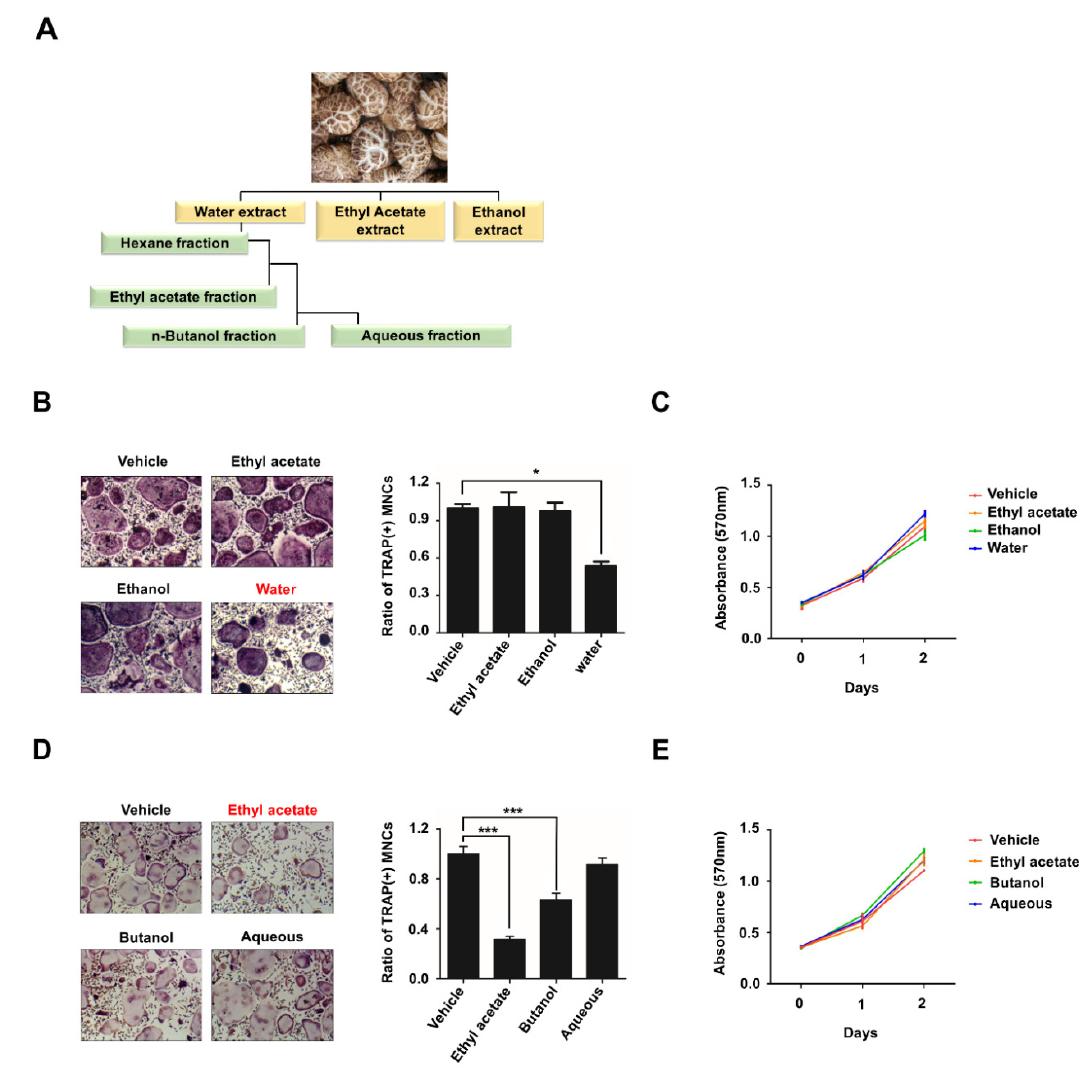
Figure 1. Ethyl acetate fraction of aqueous extract of Lentinula edodes inhibits RANKL-mediated osteoclastogenesis. ( A ) Schematic representation showing the extraction and fractionation of anti-osteoclastic compounds from L. edodes . ( B ) BMMs were treated with M-CSF (30 ng / mL) and RANKL (100 ng / mL) in the presence or absence of 10 µ g / mL three extract (water extract, ethyl acetate extract, ethanol extract) of L. edodes for three days, and osteoclast formation was examined by tartrate-resistant acid phosphatase (TRAP) staining ( left ) and counting the number of TRAP-positive multinuclear osteoclasts ( right ). ( C ) BMMs were treated with M-CSF (30 ng / mL) and RANKL (100 ng / mL) in the presence of the extracts as in ( B ), and cell proliferation was measured by MTT assays. ( D ) BMMs were treated with M-CSF (30 ng / mL) and RANKL (100 ng / mL) in the presence of four fractions (10 µ g / mL) of water extract of L. edodes for three days, and osteoclast di ff erentiation was assessed by TRAP staining (left) and the number of TRAP-positive multinuclear osteoclasts (right) was counted. ( E ) BMMs were treated with the fractions as in (D), and cell proliferation was measured by MTT assays. Error bars represent the mean result ± SD of three independent experiments; * p < 0.05, *** p < 0.001. 2.2. LEA Modulates a Set of Osteoclast-Related Gene Expression in RANKL-Induced Osteoclastogenesis To elucidate the inhibitory mechanism of LEA on RANKL-induced osteoclast differentiation, we performed genome-wide transcriptome analysis of BMMs with or without LEA during RANKL- mediated osteoclastogenesis. Analysis of RNA-seq data revealed 4740 differentially expressed genes in any pairwise comparison among the three conditions (no RANKL (-R), RANKL (R), RANKL + LEA (R+LEA)). K-means clustering classified the genes into six gene clusters that were differentially